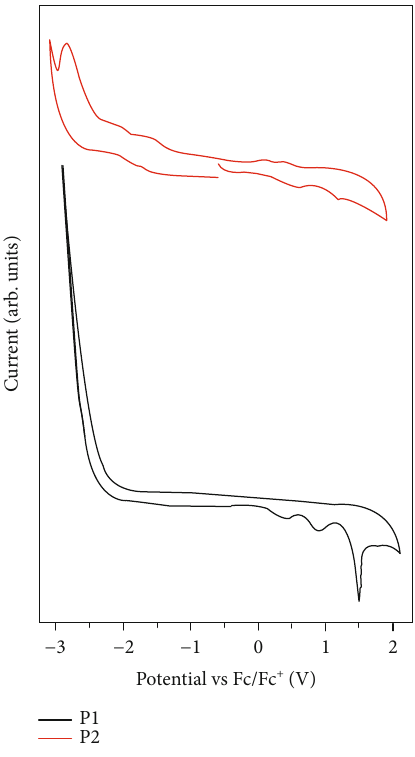
Figure 5: Cyclic voltammograms of the polymer thin fi lms. Note that these curves are both fi rst scans of cyclic